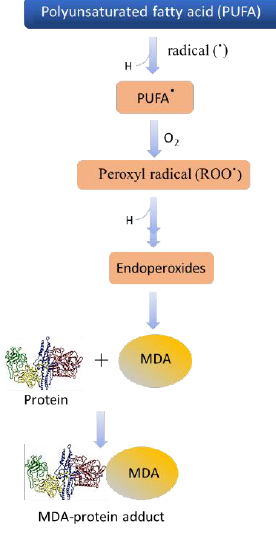
Figure 7. Quantification of protein bands from an anti-MDA blot (Figure 6) by densitogram analysis is shown and selected proteins are indicated with respective molecular weight (red).